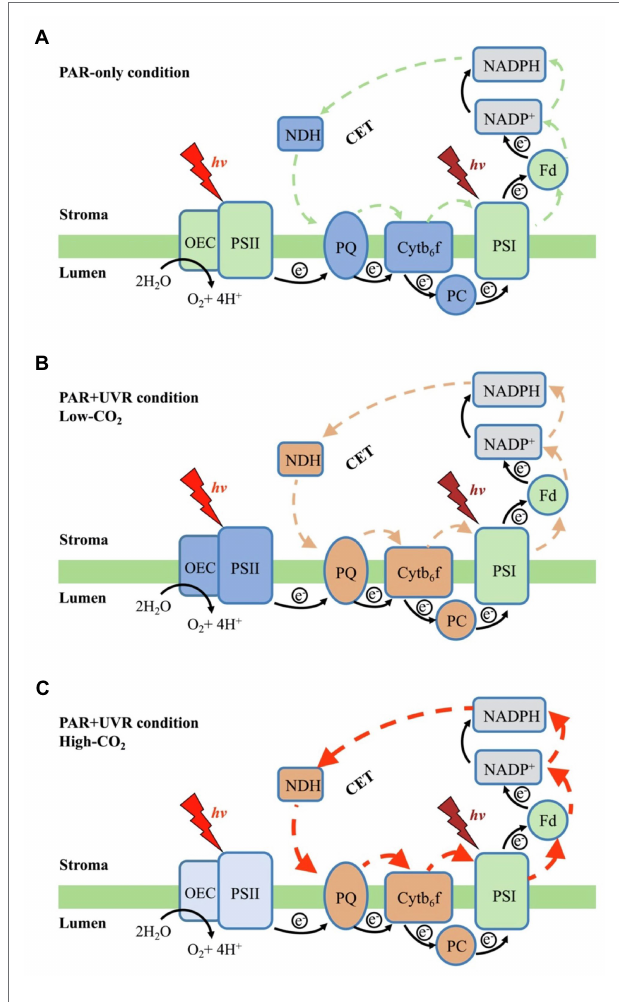
FIGURE 7 | Schematic representation of the coordination in P. yezoensis photosynthetic electron transport when exposed to PAR-only (A) , or to PAR + UVR under low-CO 2 (B) or high-CO 2 (C) concentrations. The green area indicates a normal state, the dark blue areas indicated a more severe inhibition, the light blue indicates a moderate inhibition, the orange area indicates an up-regulation, and the gray areas represent the unmeasured sites. Black arrows indicate linear electron transport flow, the colored arrows CET around PSI and the orange/red arrows indicate the up-regulation of